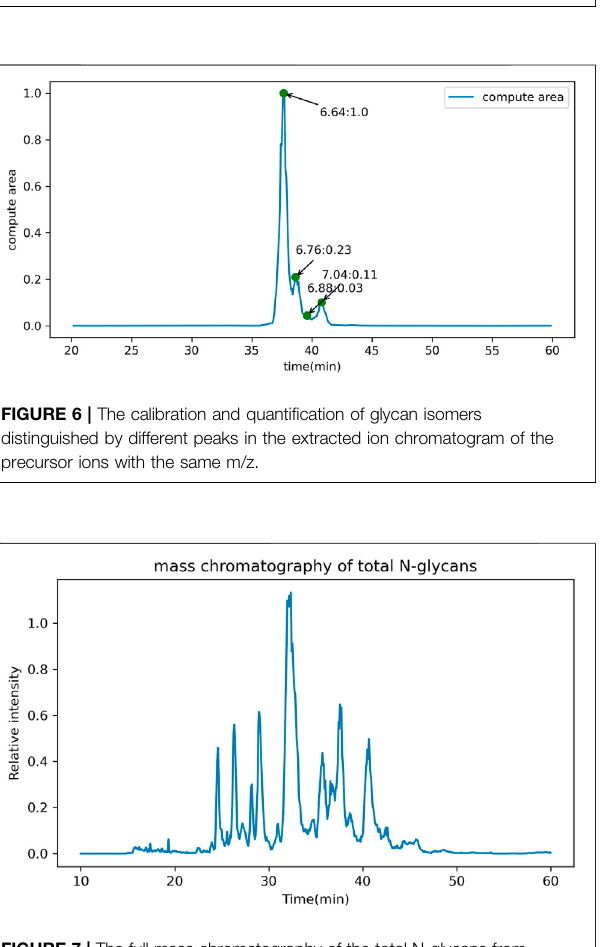
Frontiers in Chemistry |